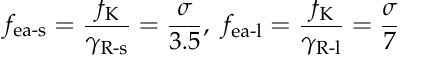
Table 5. The tensile strength values of ETFE membrane material under different strain rates. The Tensile Strength σ /MPa Average Strain Rate